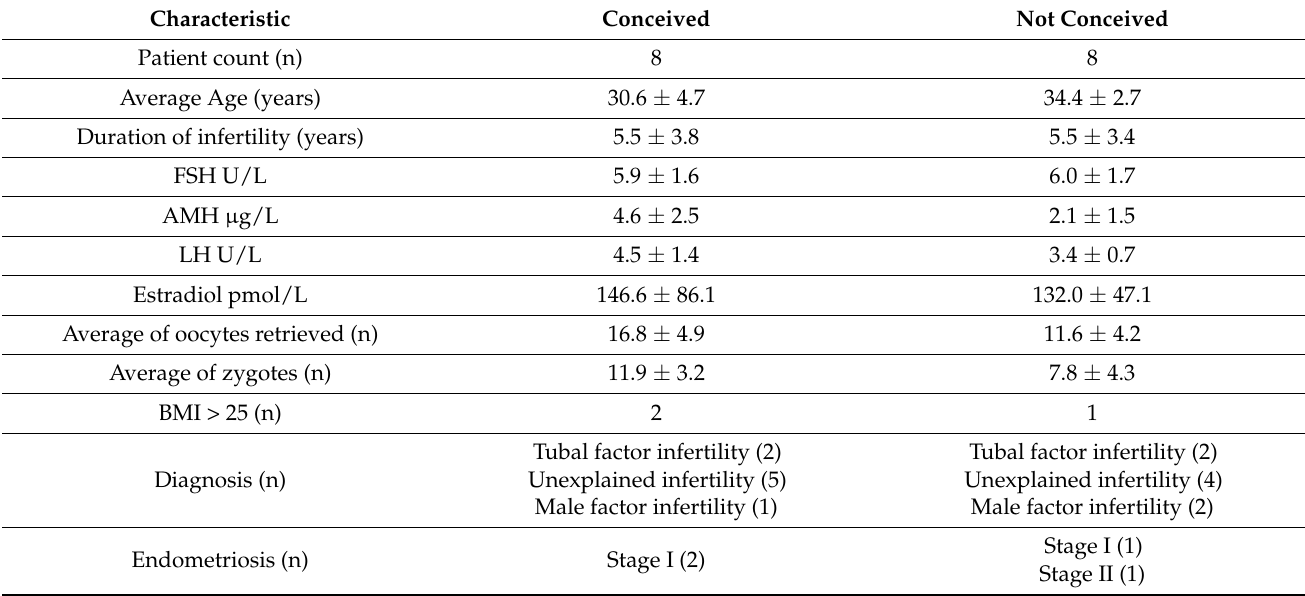
Table 1. Clinical data of the study